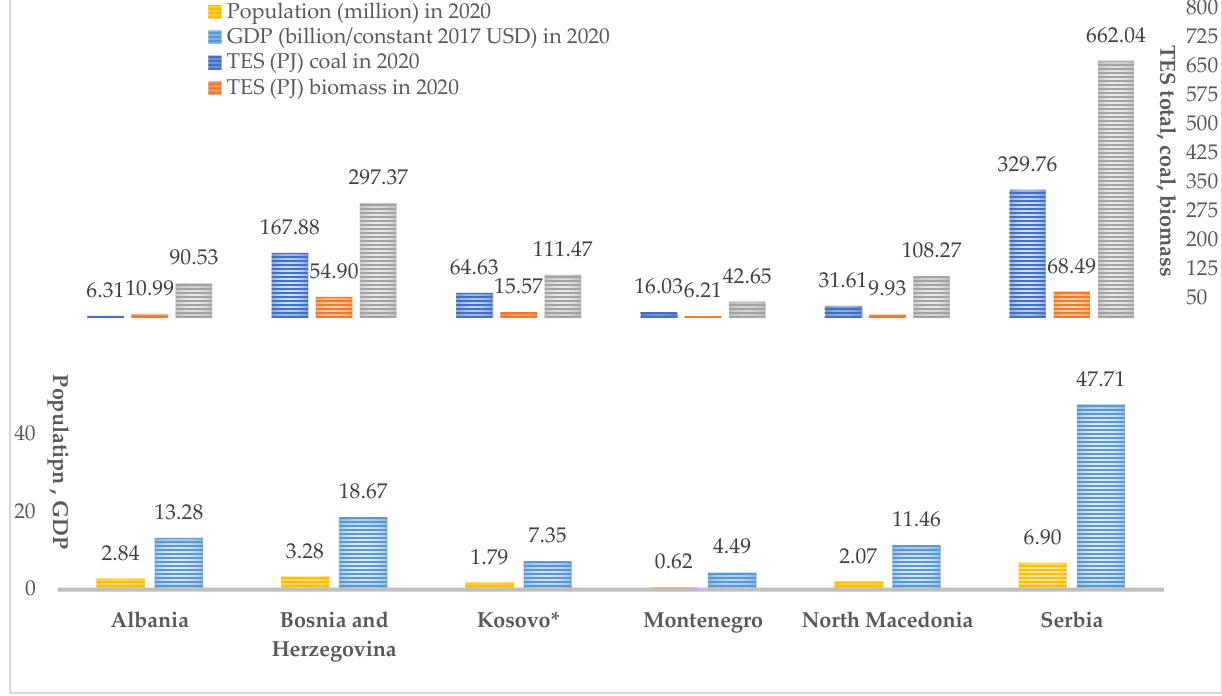
Figure 1. Comparison of WB countries on the main indicators that justify the decision to study Serbia and the context of the carbon-intensive, biomass-abundant framework [30,31].